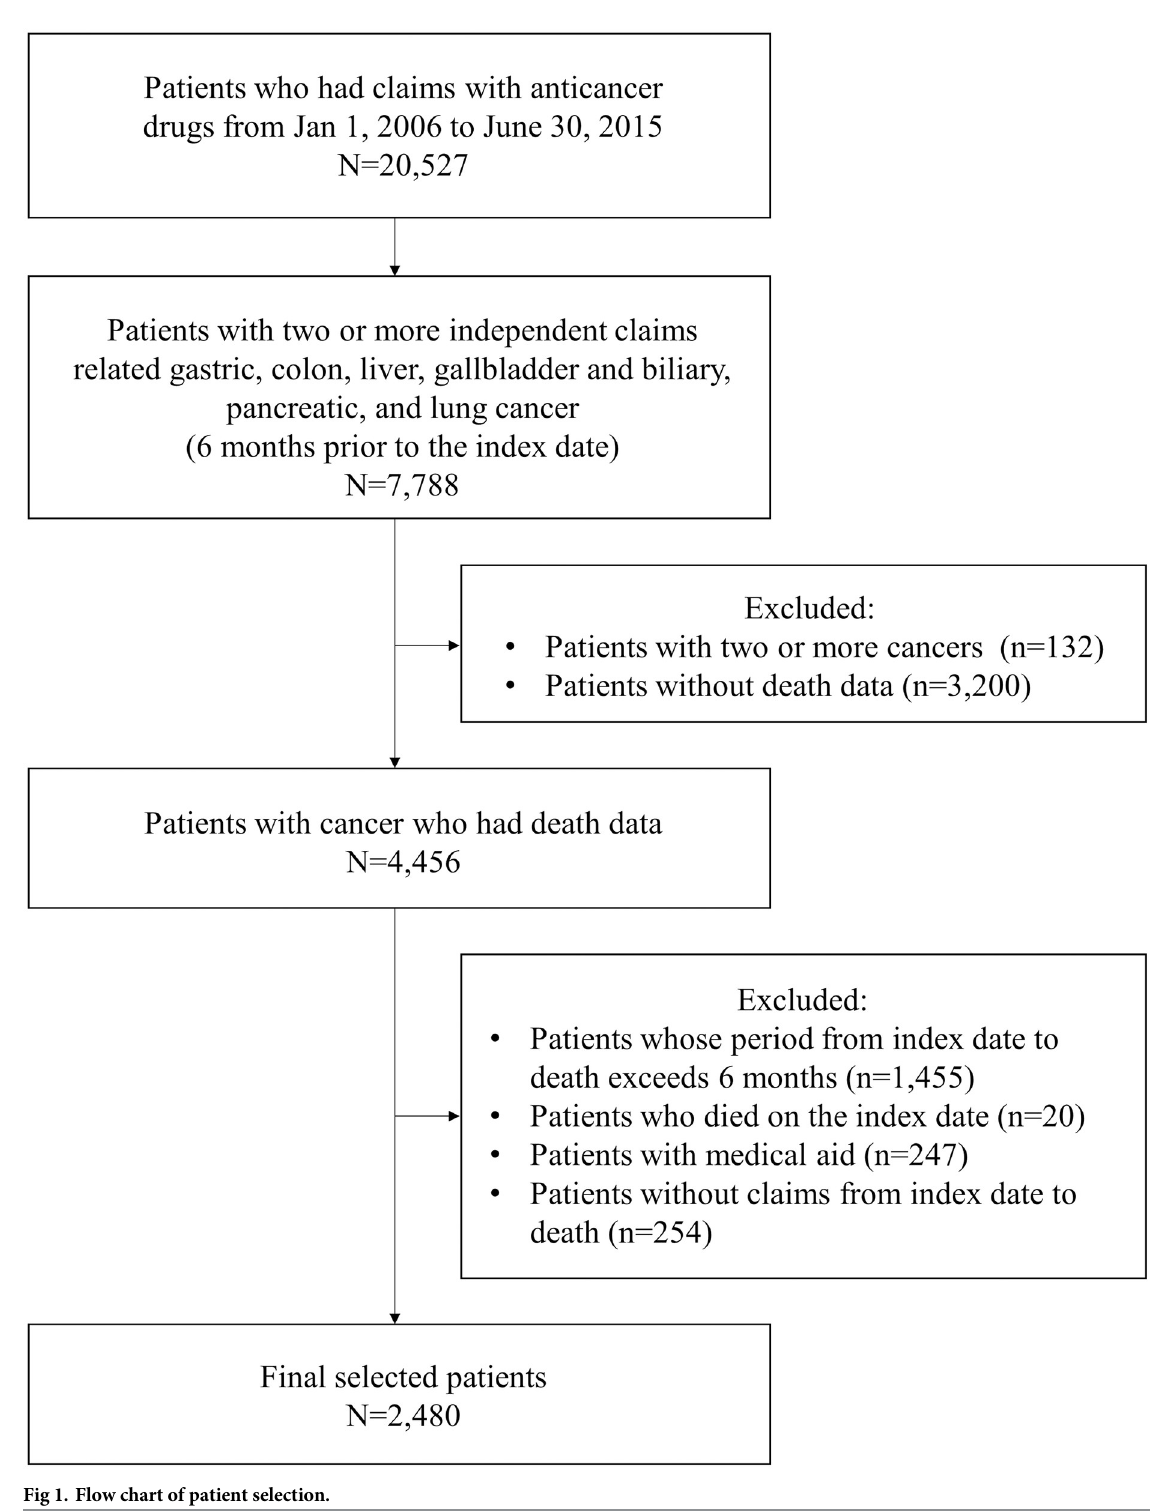
Fig 1. Flow chart of patient selection.